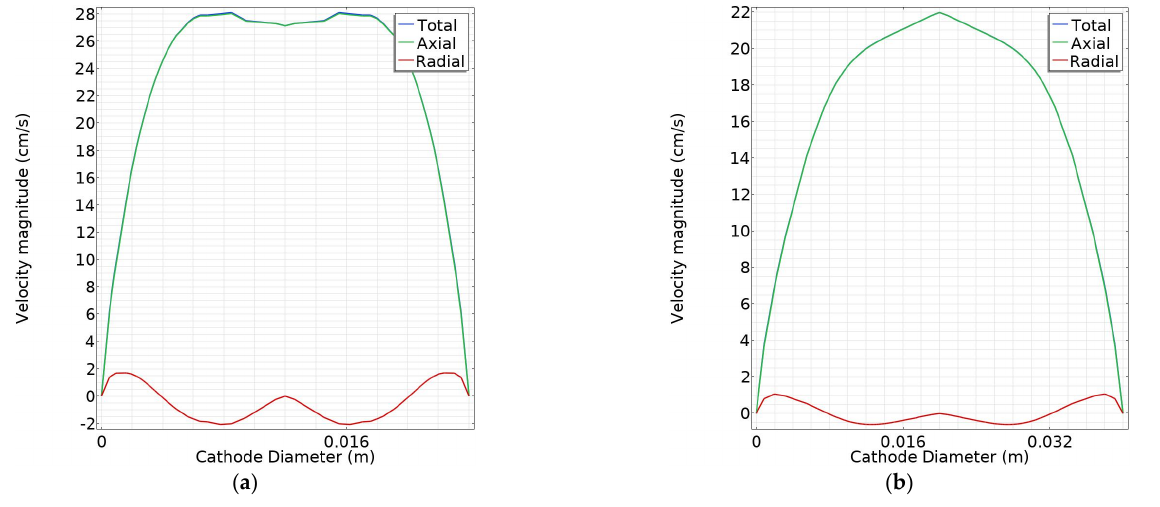
Figure 7. Fluid velocity components at exit of the EHD thruster (cm/s) for the optimal thruster out ‐ put: ( a ) thruster with argon as propellant gas; ( b ) thruster with xenon as propellant